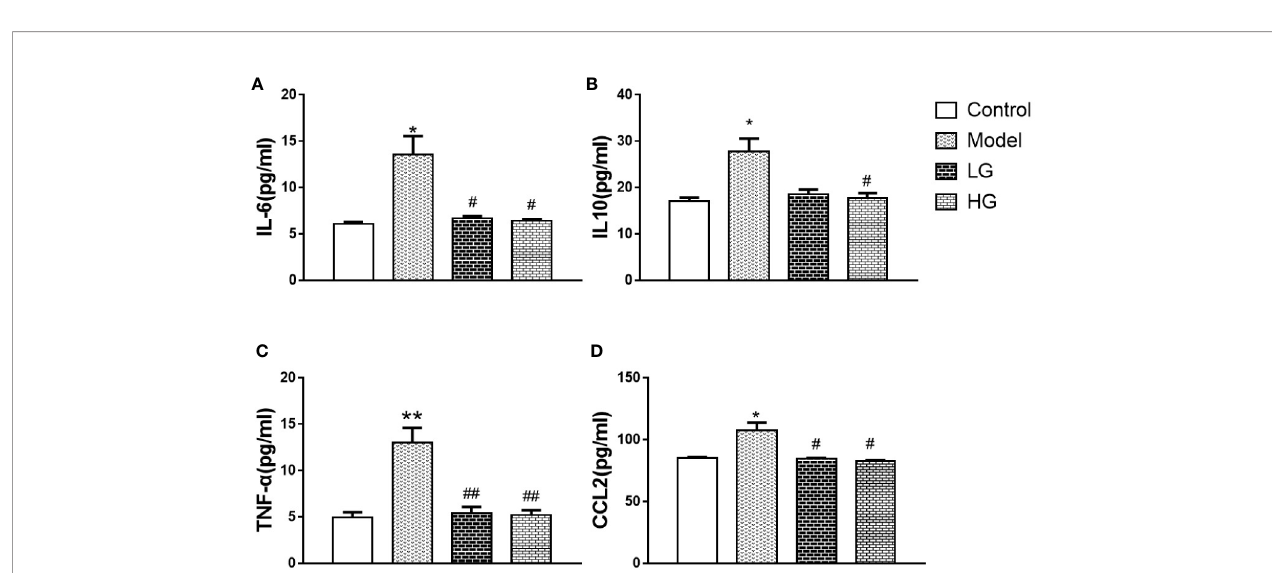
FIGURE 4 | In fl ammatory factors and chemokines in the microenvironment of hepatocellular carcinoma are down-regulated by GHJCD. (A) IL-6 content in liver tissue. (B) IL-10 content in liver tissue. (C) Expression of TNF- a in the liver. (D) CCl-2 content in liver tissue. IL-6, IL-10, TNF- a , and CCl-2 data in the liver cancer microenvironment were analyzed by ANOVA. The homogeneity test was fi rst performed, P > 0.05, the variances were uniform, and the LSD (L) test was used for multiple comparisons afterward, P < 0.05, the variances were not uniform.*p < 0.05 vs. control; # p < 0.05, ## p < 0.01 vs. model. Data were analyzed using single- variance t